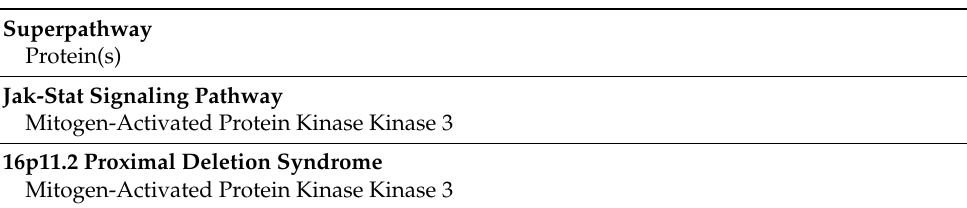
Table A2. Associated superpathways of the identified proteins, in the order of ascending number of associated superpathways. (Information retrieved from the resources detailed in the Materials and